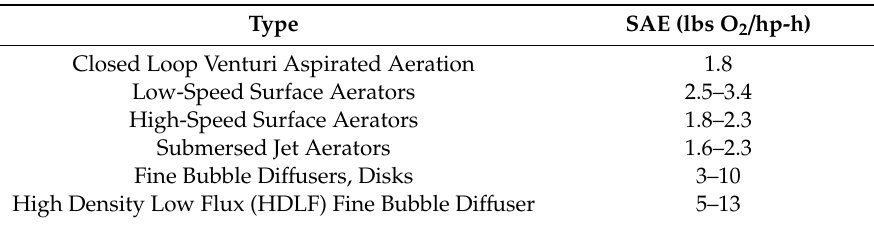
Table 6. Efficiency of different aeration systems.